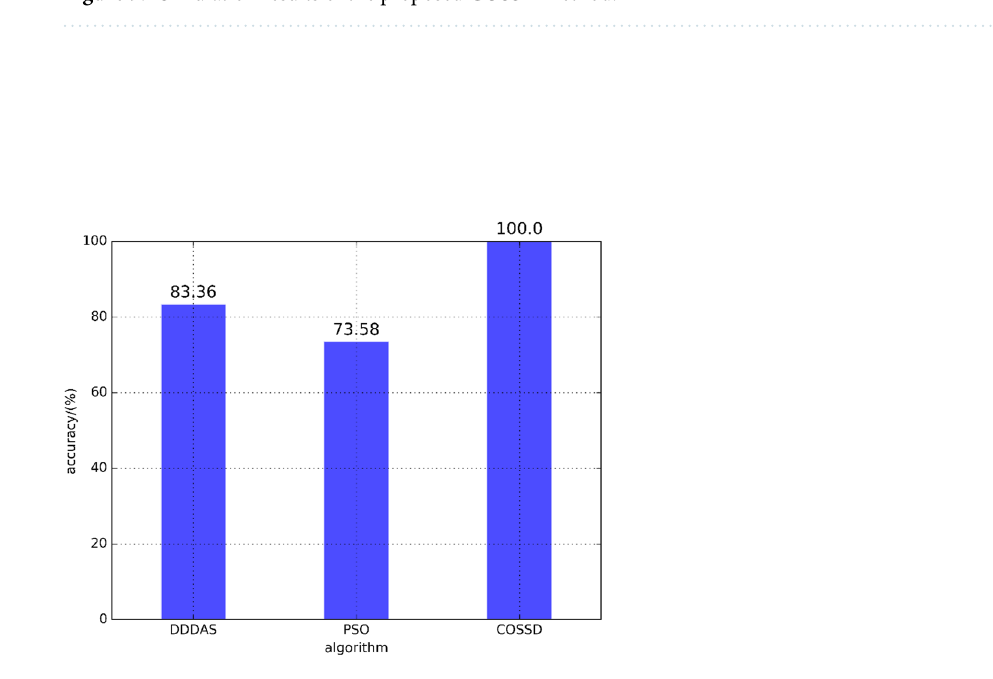
Figure 8. The accuracy comparison of the DDDAS-based oil spill detection approach, the PSO method, and the proposed COSSD